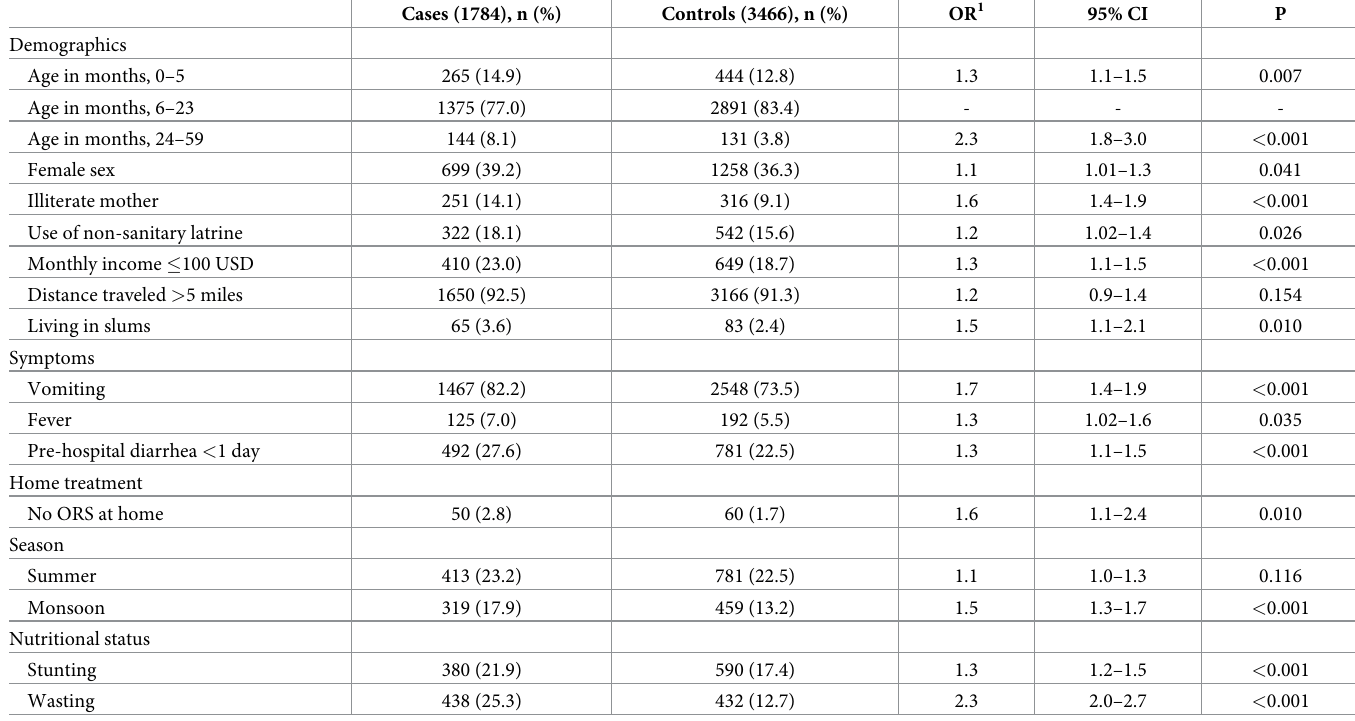
Table 1. Characteristics of rotavirus-infected under-five children with (cases) or without (controls) clinical dehydration in